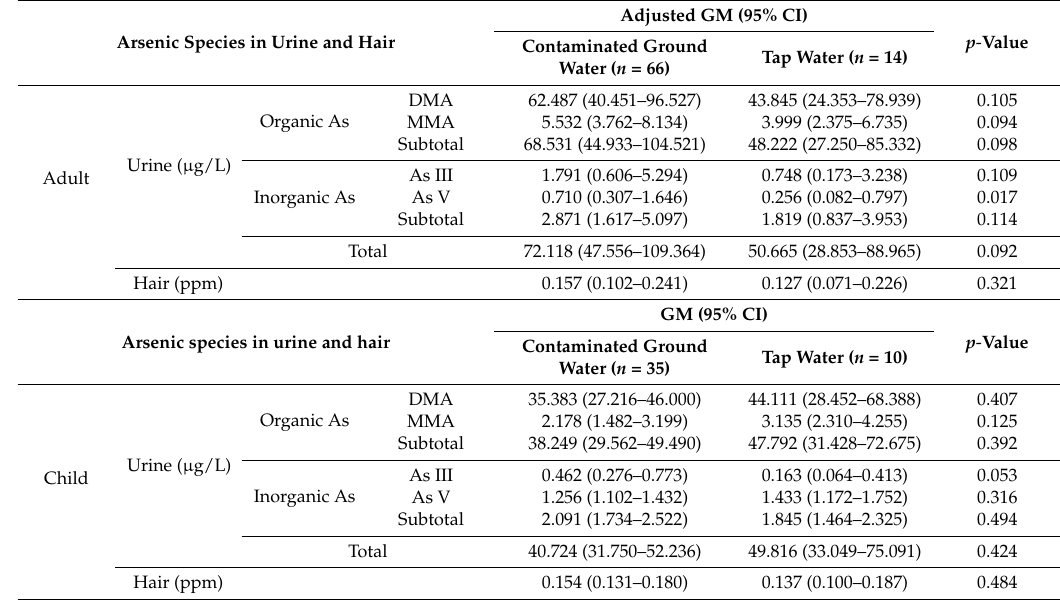
Table 3. Comparison of arsenic concentrations between the adult and child exposure groups according to source of drinking